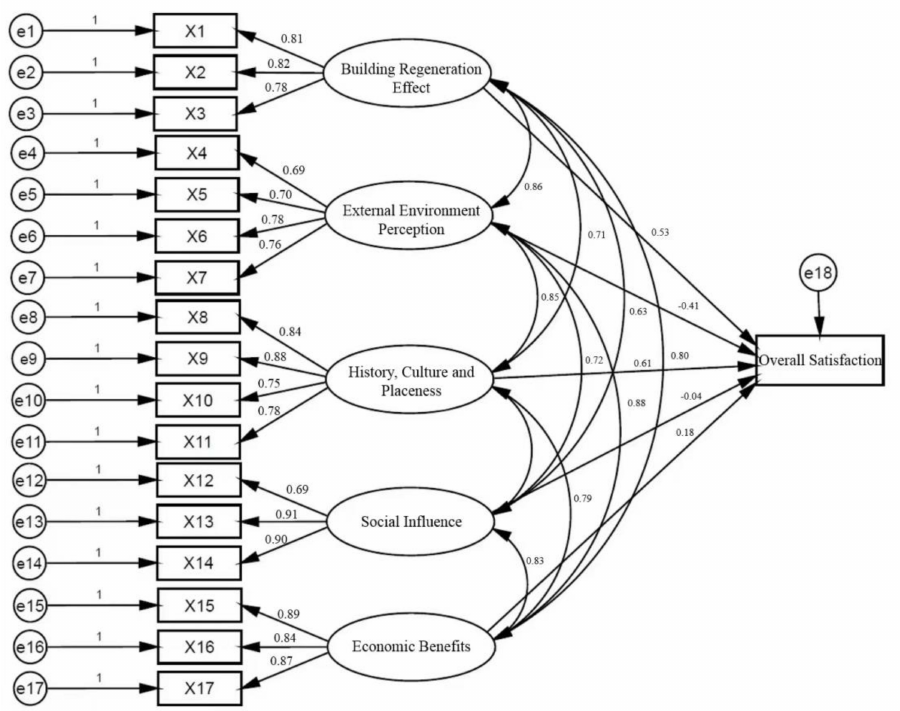
Figure 5. The final structural equation